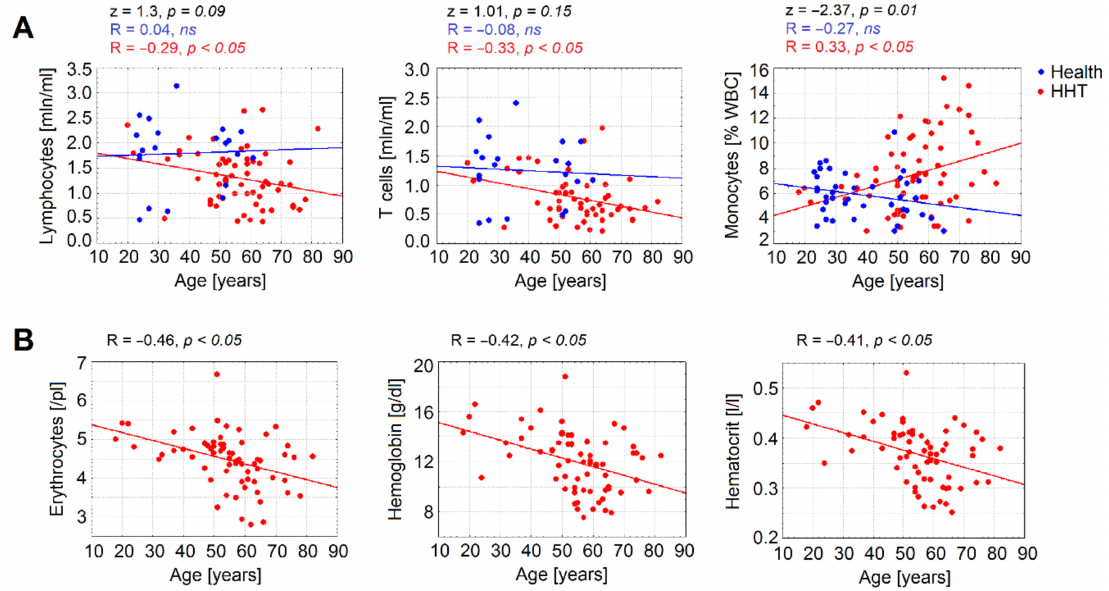
Figure 2. Age-related decline in immune and red blood parameters in HHT. ( A ) Age-dependent amounts of monocytes, lymphocytes, and T cells were analyzed in patients with hereditary hemorrhagic telangiectasia (HHT) compared to healthy controls. ( B ) Absolute number of erythrocytes, hemoglobin, and hematocrit decreased in patients with HHT. Data are presented as individual levels; Spearman R test was used to assess the correlations, and comparison of correlations was performed using Fisher’s r to z transformation and z test. Healthy: number of persons (n) = 23, HHT: n = 40, HHT = hereditary hemorrhagic